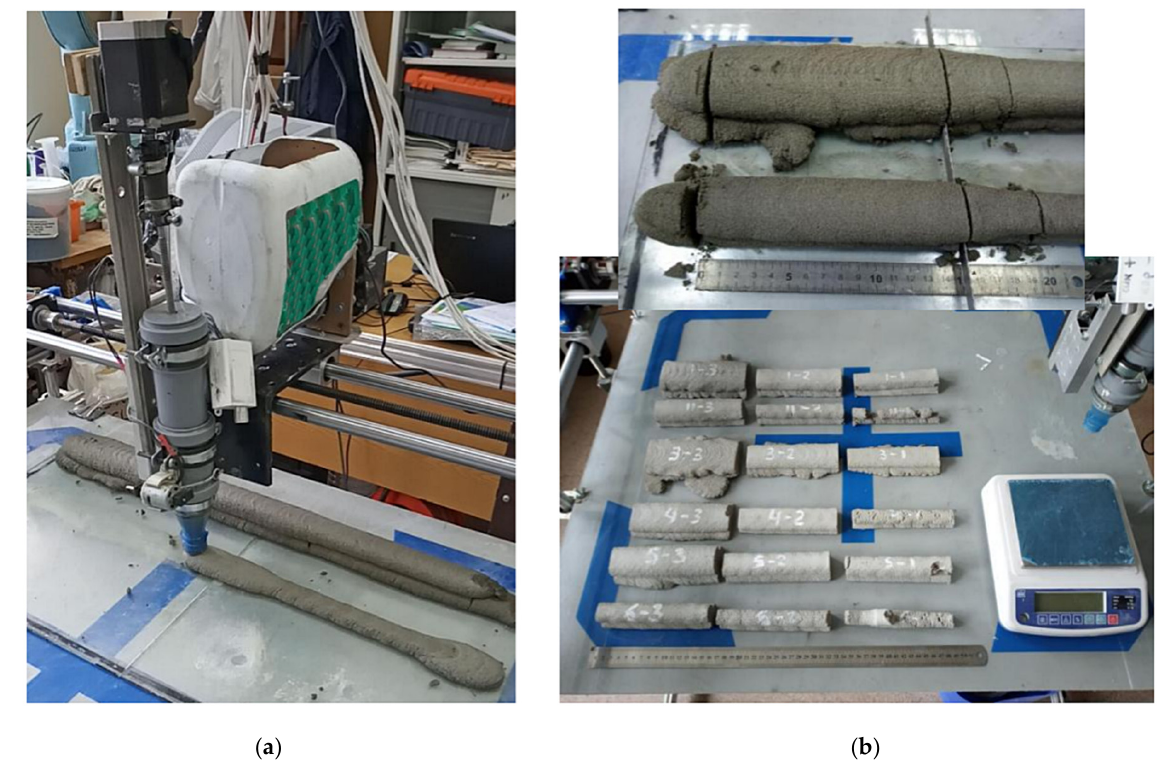
Figure 2. Printing process and preparation of test samples: ( a ) track printing process; ( b ) cutting the track into samples with a length of ≈ 15 cm, and a general view of the samples prepared for the experiment.